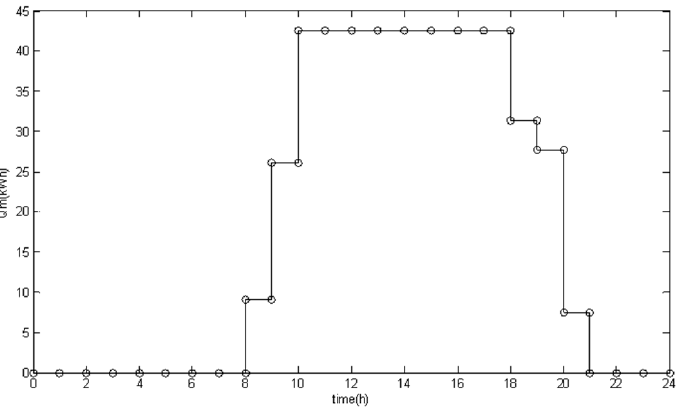
Figure 14. Output heat of the micro-turbines.